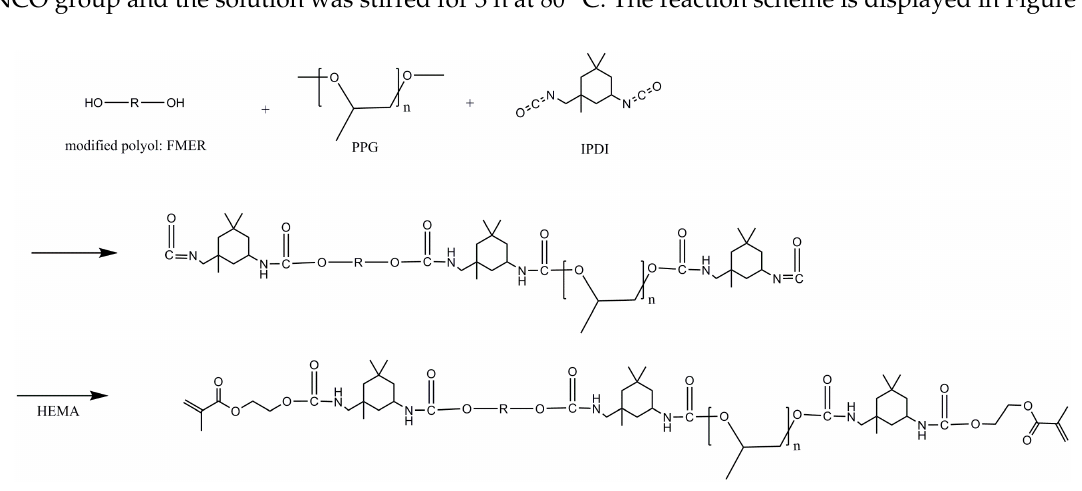
Figure 2. Reaction scheme for PU by reacting the fatty acid-modified hydrogenated epoxy polyol with isophorone diisocyanate (FMEP-PU).